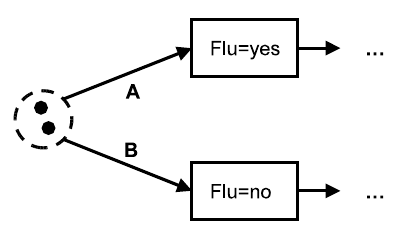
Fig. 4. A Place in Two Upper